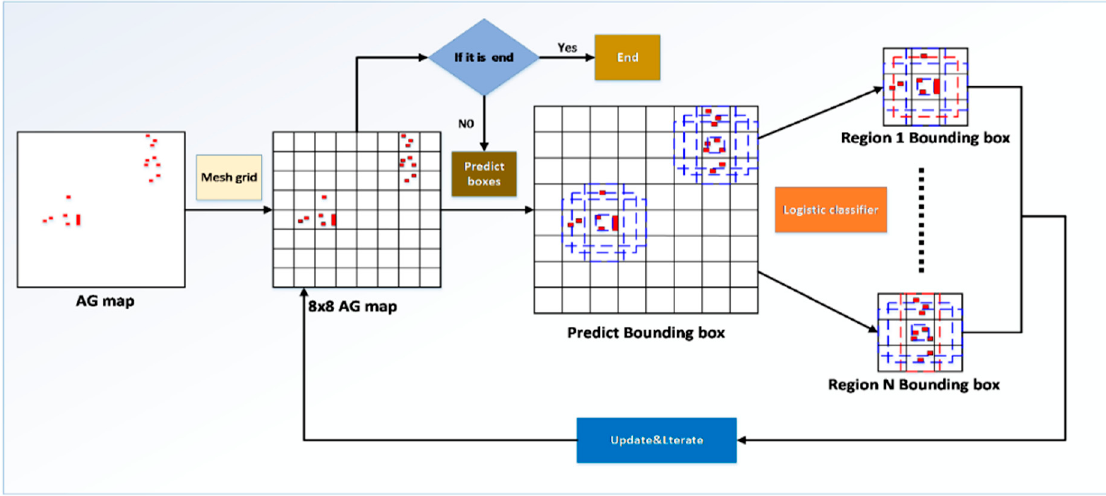
Figure 8. Dynamic zoom area selection process.